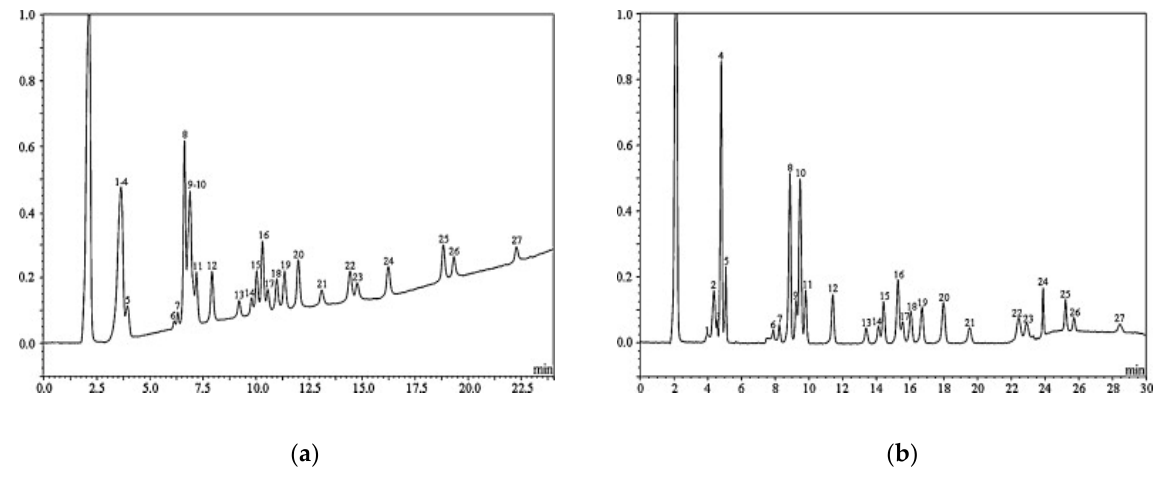
Figure 3. HPIC anion-exchange chromatogram of a reference sample separated using ( a ) gradient elution with HCl on CarboPac PA100 column, and ( b ) gradient elution with MSA on CarboPac PA1 column. Peak numbers correspond to the following isomers of inositol phosphates: (1–5) InsP2, (6) Ins(1,3,5)P3, (7) Ins(2,4,6)P3, (8–11) InsP3, (12) DL -Ins(1,5,6)P3, (13) DL -Ins(4,5,6)P3, (14) Ins(1,2,3,5)P4, (15) DL -Ins(1,2,4,6)P4, (16) DL -Ins(1,2,3,4)P4, (17) Ins(1,3,4,6)P4, (18) DL -Ins(1,2,4,5)P4, (19) DL -Ins(1,3,4,5)P4, (20) DL -Ins(1,2,5,6)P4, (21) Ins(2,4,5,6)P4, (22) DL -Ins(1,4,5,6)P4, (23) Ins(1,2,3,4,6)P5, (24) DL -Ins(1,2,3,4,5)P5, (25) DL -Ins(1,2,4,5,6)P5, (26) Ins(1,3,4,5,6)P5, (27) InsP6. Reprinted with permission from Elsevier [113].